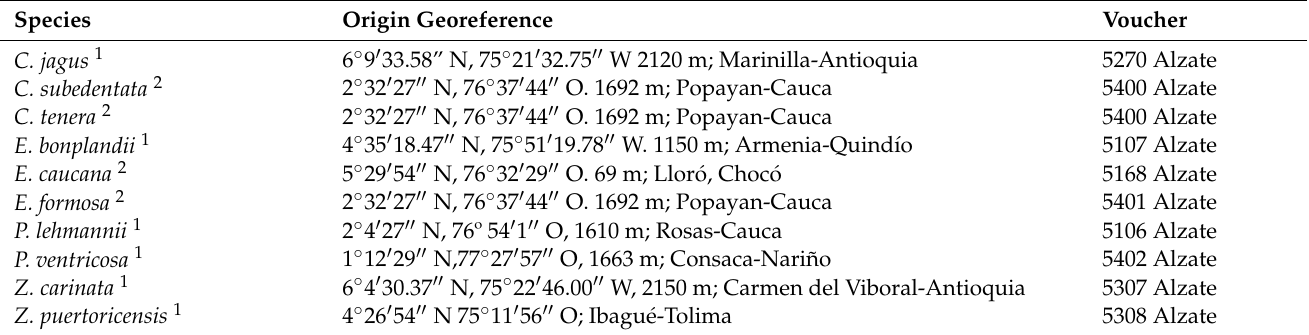
Table 1. Geographical origin of the collected Amaryllidaceae species.